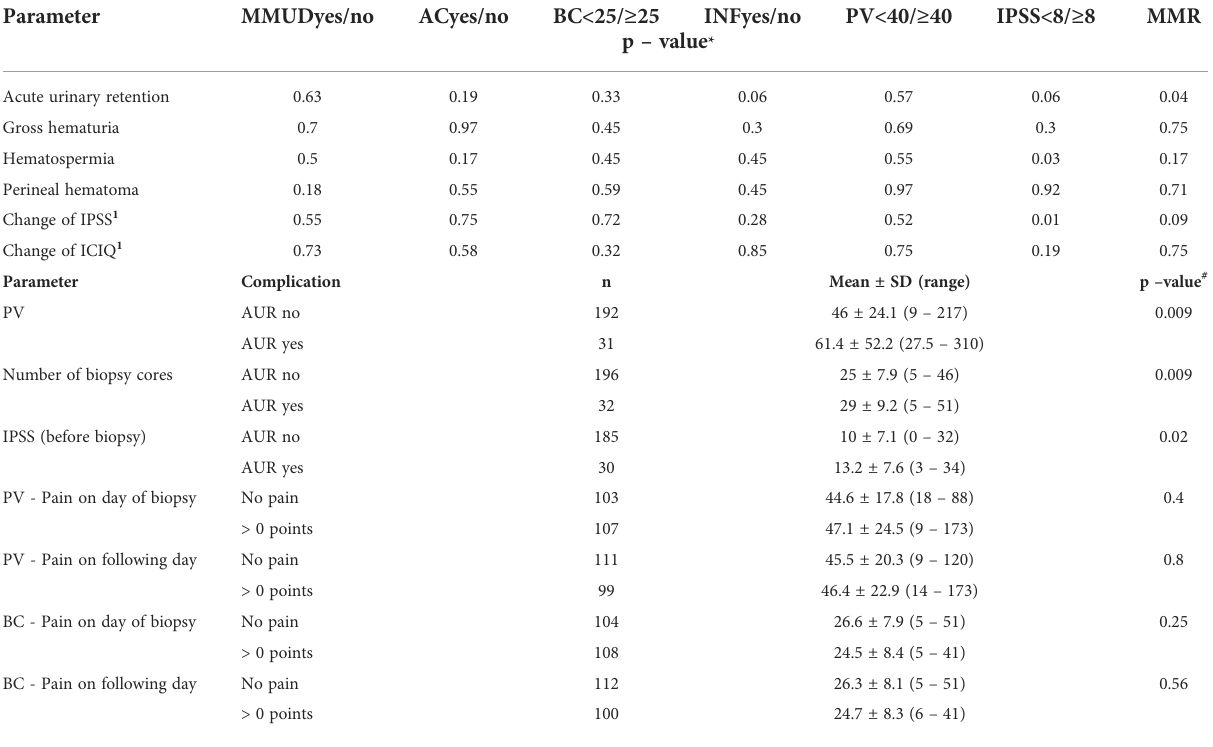
TABLE 3 Functional outcome and side-effects - Subgroup